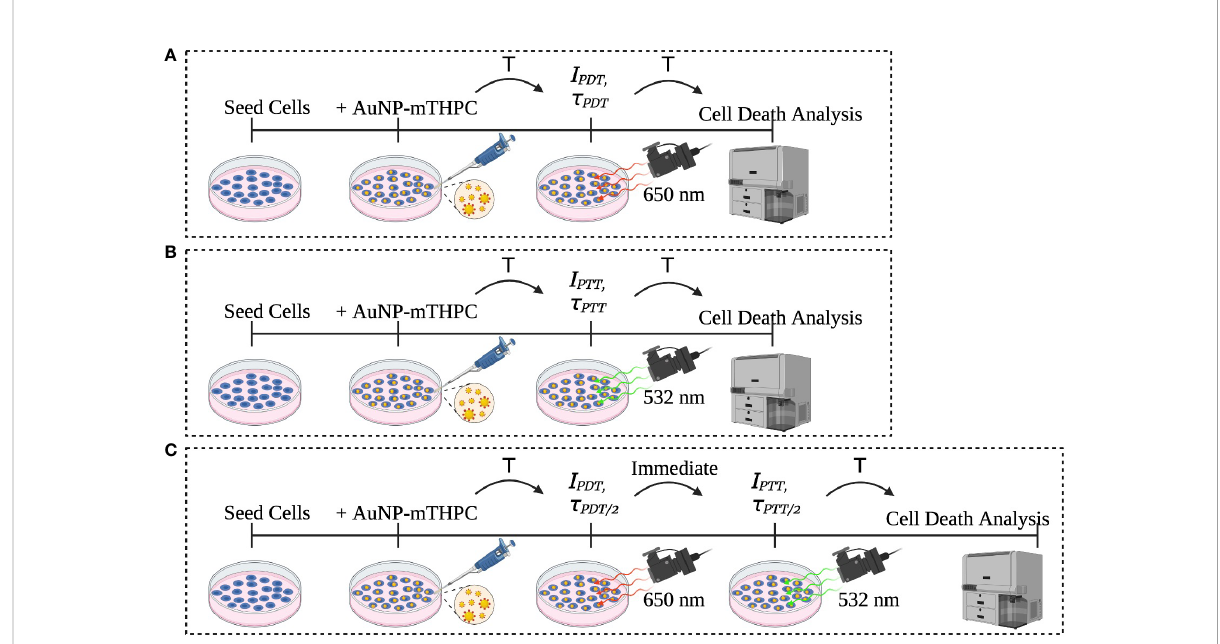
FIGURE 1 Description of the experiment sets: (A) PDT, (B) PTT, and (C) the combined PDT and PTT